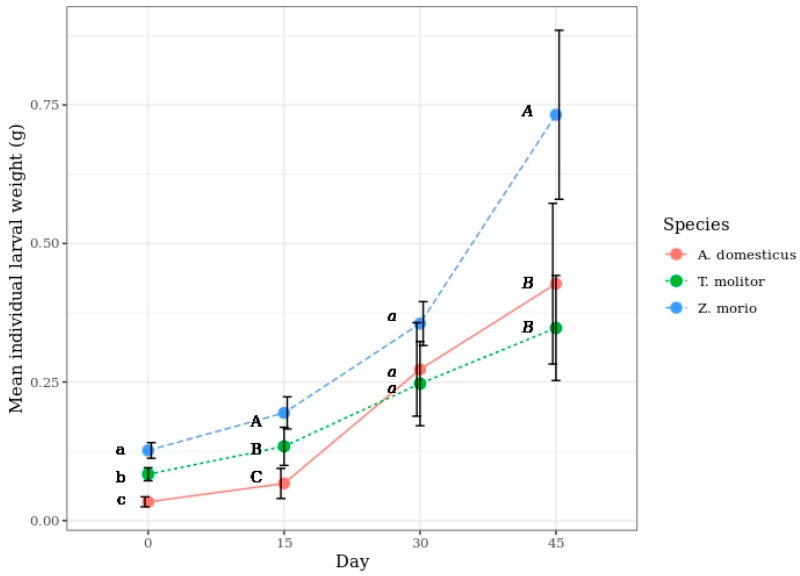
Figure 2. Mean individual larval weight of T. molitor , Z. morio, and A. domesticus when reared on the different substrates, by time (the bars indicate the 95% confidence interval). Different letters show statistically significant differences among the species.